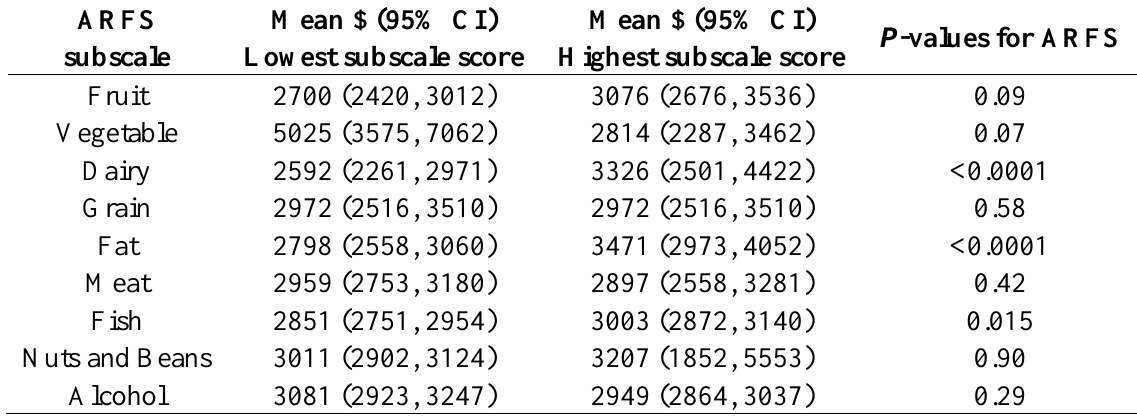
Table 2. Generalised Linear Models of five year cumulative Medicare Charges for mid-aged Australian women, adjusted for area of residence and educational attainment, against sub-scale component scores of the Australian Recommended Food Score (ARFS), where 1 = lowest and 5 = highest